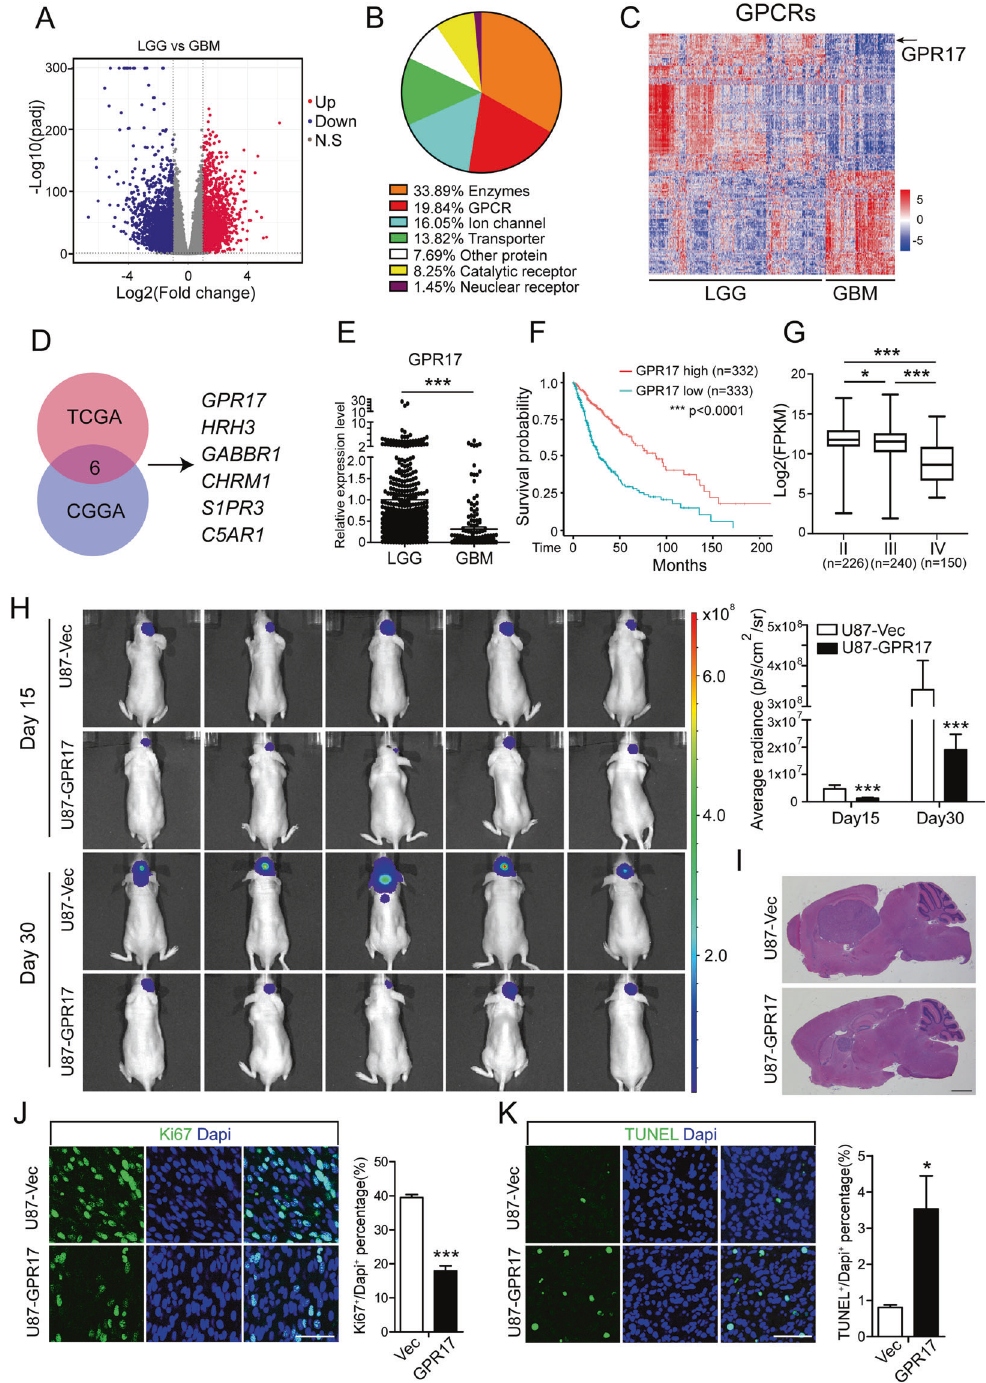
Fig. 1 GPR17 suppressed glioma tumorigenesis. A Volcano plot of the differentially expressed protein-coding genes between LGG ( n = 511) and GBM ( n = 156) from the TCGA cohort. B Pie chart showing the proportions of the drug targets in differentially expressed genes. C Heatmap analysis of the differentially expressed GPCRs between LGG and GBM patients from TCGA dataset. Gene expression values were z - transformed and were colored red for high expression and blue for low expression. Black arrow indicated GPR17. D Venn diagram showing the differentially expressed GPCRs found in both TCGA and CGGA database after screening. E mRNA levels of GPR17 in LGG ( n = 511) and GBM ( n = 156) patients from the TCGA cohort. F Kaplan – Meier analysis of patients overall survival data based on high versus low expression of GPR17 in glioma, grades II – IV, from the TCGA dataset. P values were obtained from the log-rank test. *** p < 0.001, G Expression of GPR17 in grade II ( n = 226), grade III ( n = 240), and GBM ( n = 150) patients from the TCGA cohort. H BALB/c nude mice ( n = 5 per group) were xenotransplanted with U87-Vec or GPR17 -overexpressing U87MG cells through stereotatic injection. Bioluminescence imaging was performed on days 15 and 30 after xenotransplantation. Data represent the means ± SEM from fi ve mice. *** P < 0.001, Student ’ s t- test. I H&E staining of brain sections with U87-Vec and U87-GPR17 tumors. Scale bar, 300 μ m. J , K Immuno fl uorescent staining against Ki67 (J) and TUNEL ( K ) of the tumor sections. Scale bar, 50 μ